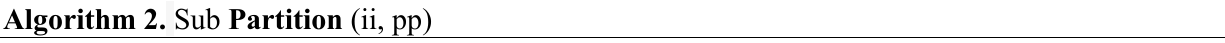
Algorithm 2. Sub Partition (ii,